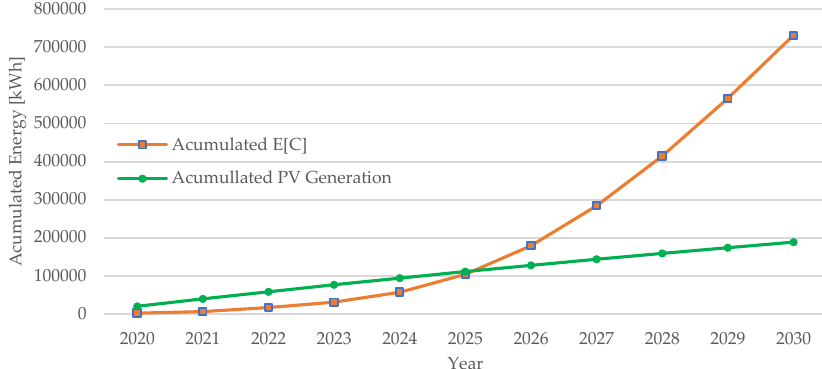
Figure 24. Comparison between the energy generated and energy consumed by recharges.